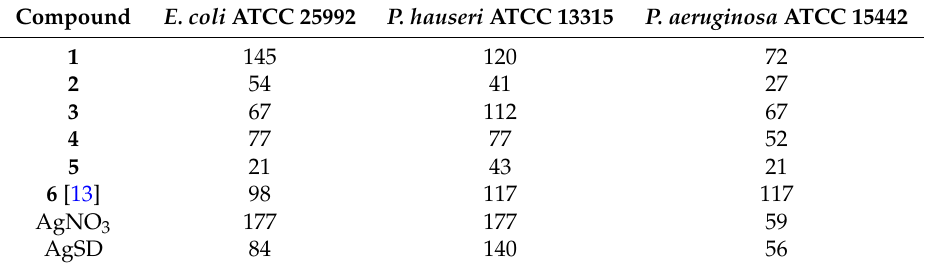
Figure 4. Antibacterial activity of the complexes 1 – 6 , given as MIC (minimum inhibitory concentration) values in µmol·L − 1 . MIC values of the free ligands, i.e. , 4-pmOpe, 2-bimOpe, 2,6-di(CH 2 OH)py, 4-CH 2 OHpy, 2-CH 2 OHbim, are > 500 mg·L − 1 . AgSD: silver sulfadiazine. The all experiments were performed in triplicate (SD = 0). * Complex 6 [13]. Table 4. MBC (minimum bactericidal concentration) values (µM) of the tested compounds. Compound E. coli ATCC